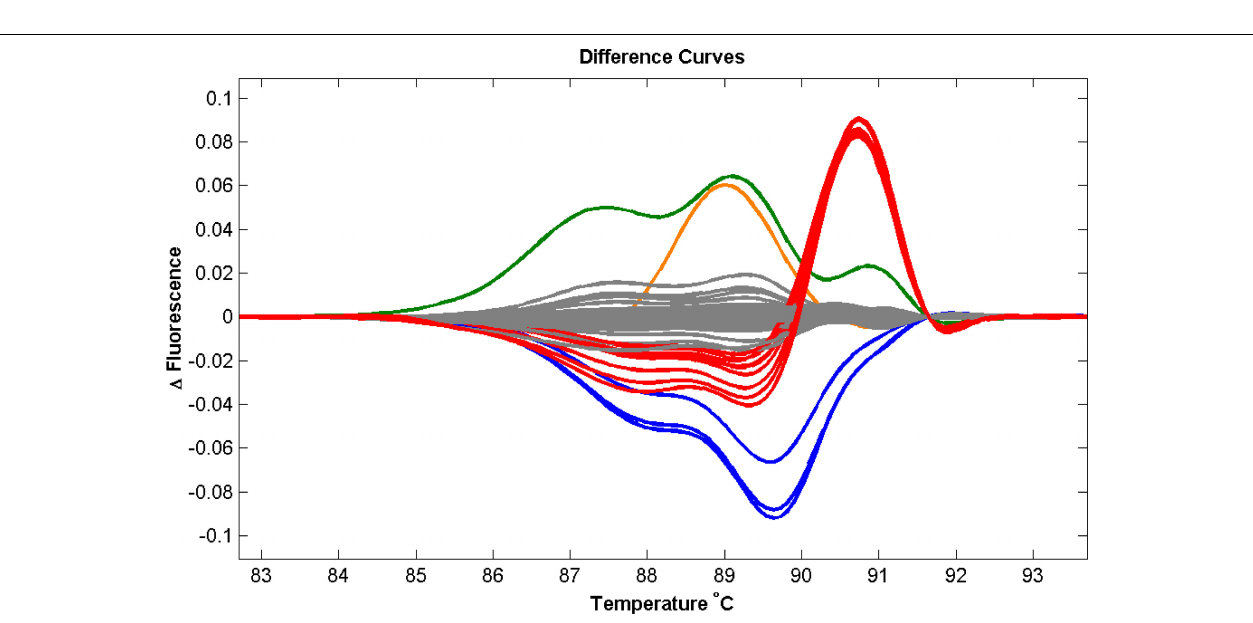
FIGURE 2 | Global origin of hyperekplexia referrals. Upper panel: A geographical representation of the global origin of hyperekplexia patients recruited to our laboratory (red) and other laboratories (blue – Information obtained from the NCBI PubMed search engine). Lower panel: Detail showing the origin of patients recruited from central